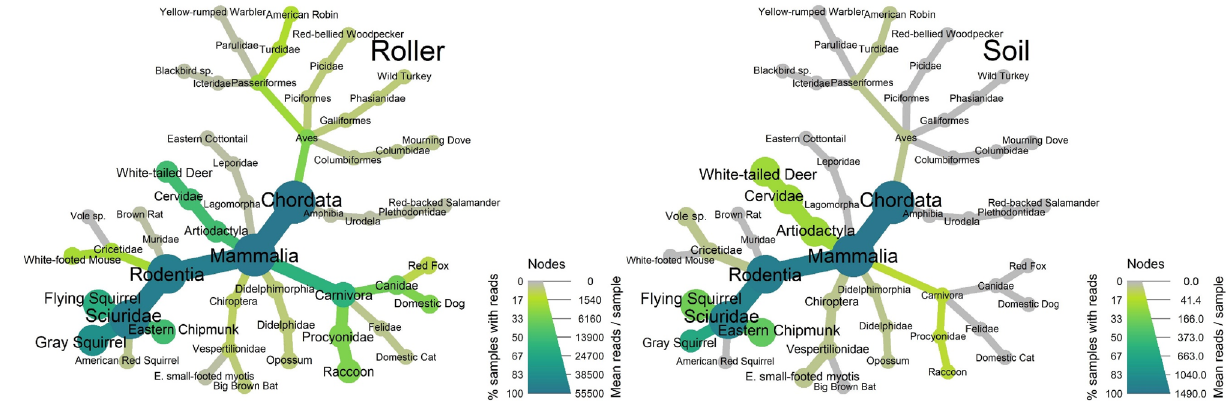
Figure 2. Taxonomic affiliation all species detected in a tree bark surface (‘roller’) and soil eDNA metabarcoding study in New Jersey, USA woodlands. The width of each node and branch shows the mean number of reads per sample, while the shading shows the percent of samples that included any reads.